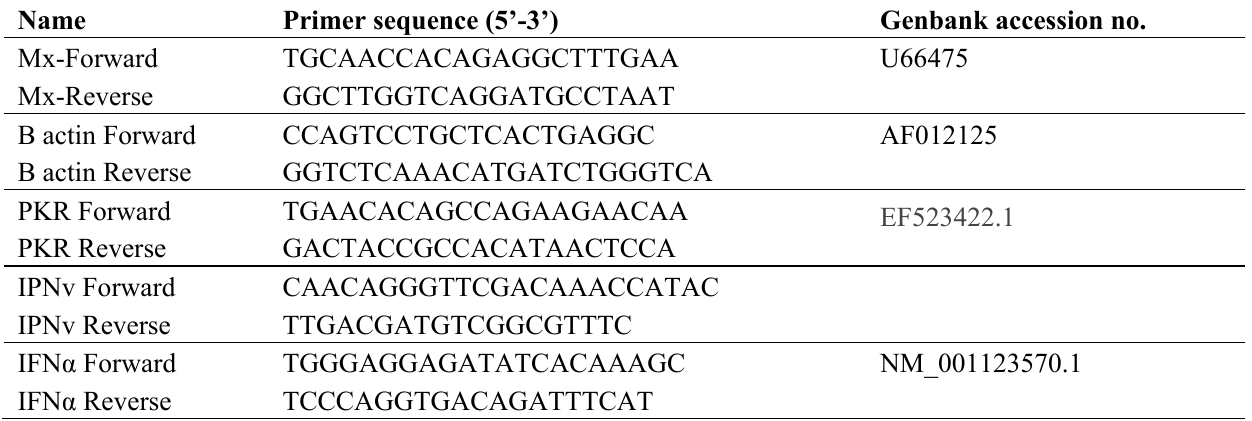
Table 1. Primer sequences used for real-time